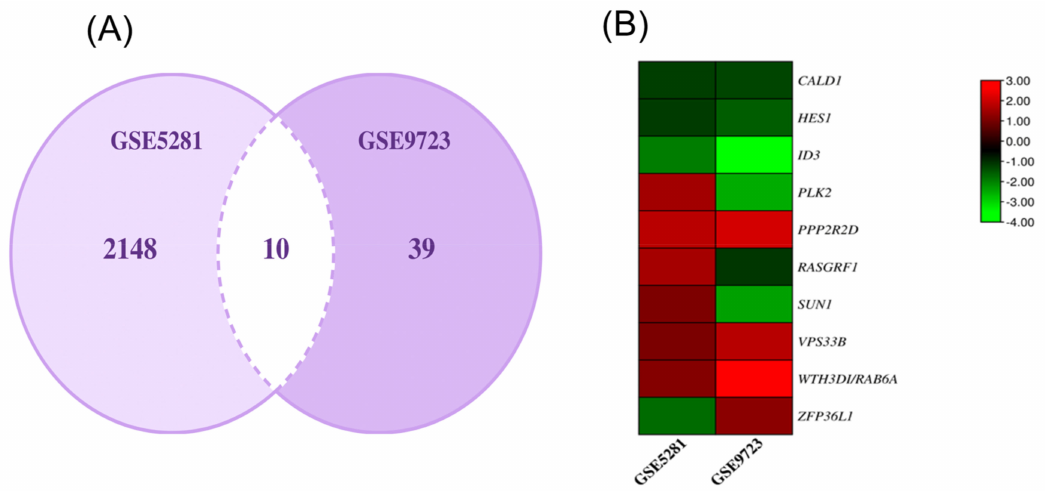
Figure 3. ( A ) Common genes and ( B ) heat map of P. gingivalis -associated